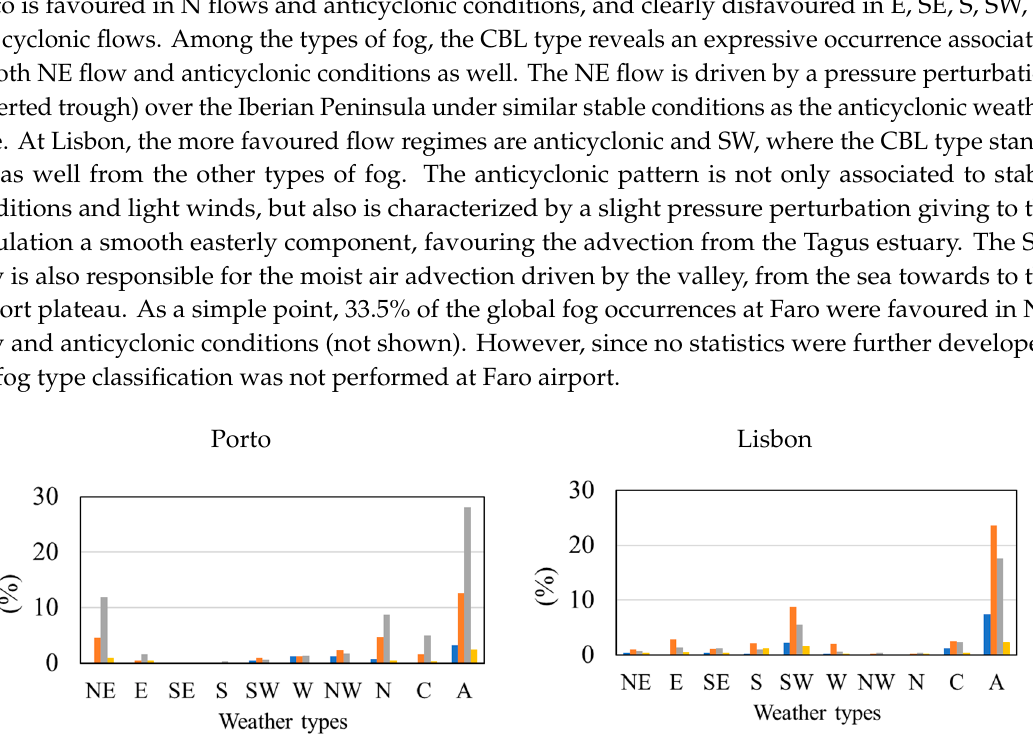
Figure 7. Monthly distribution of the event relative frequency according to the fog types at Porto ( a ) and Lisbon ( b ).